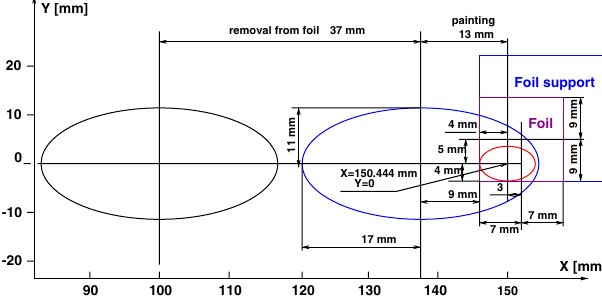
FIG. 1. Painting injection